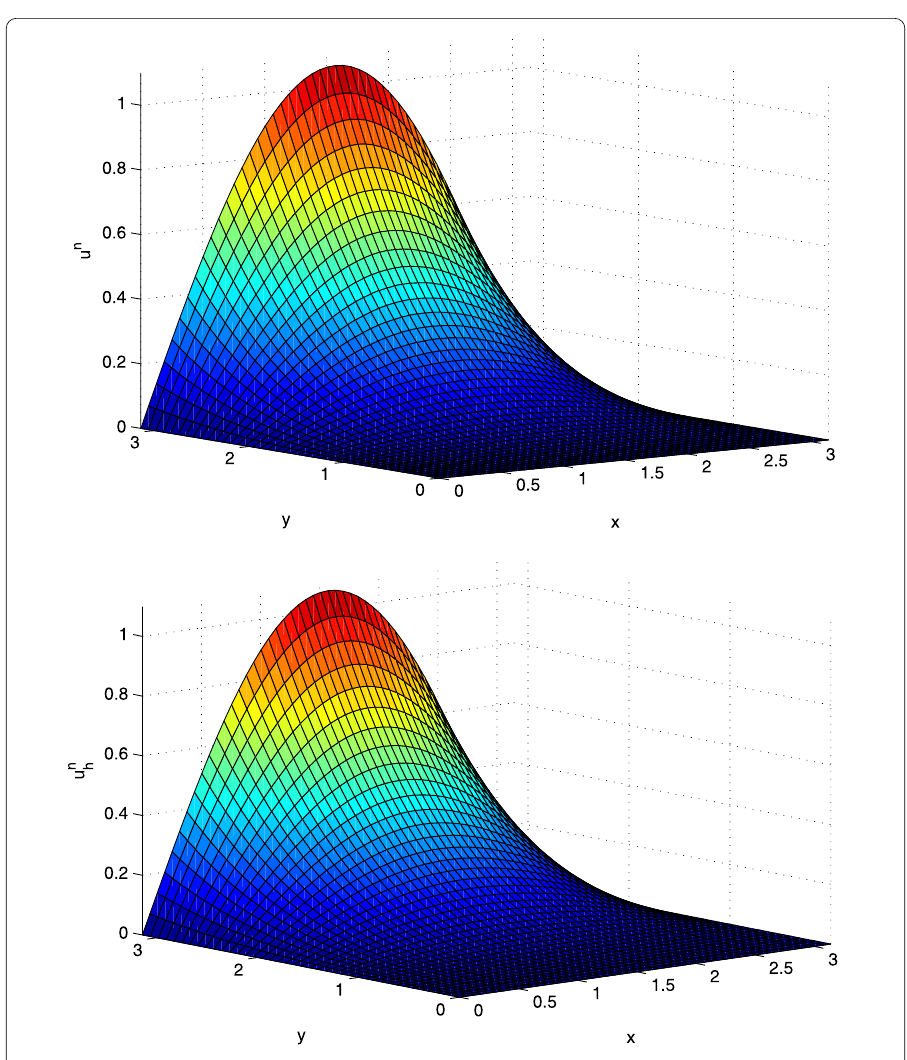
Figure 6 The exact solution (top) and numerical solution (bottom) for Example 3, when h = 0.05, τ = 0.05, α = 0.5 and T =